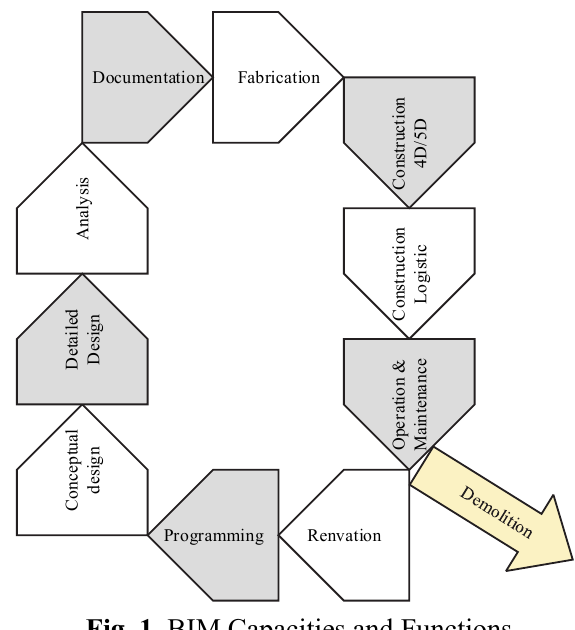
Fig. 1. BIM Capacities and